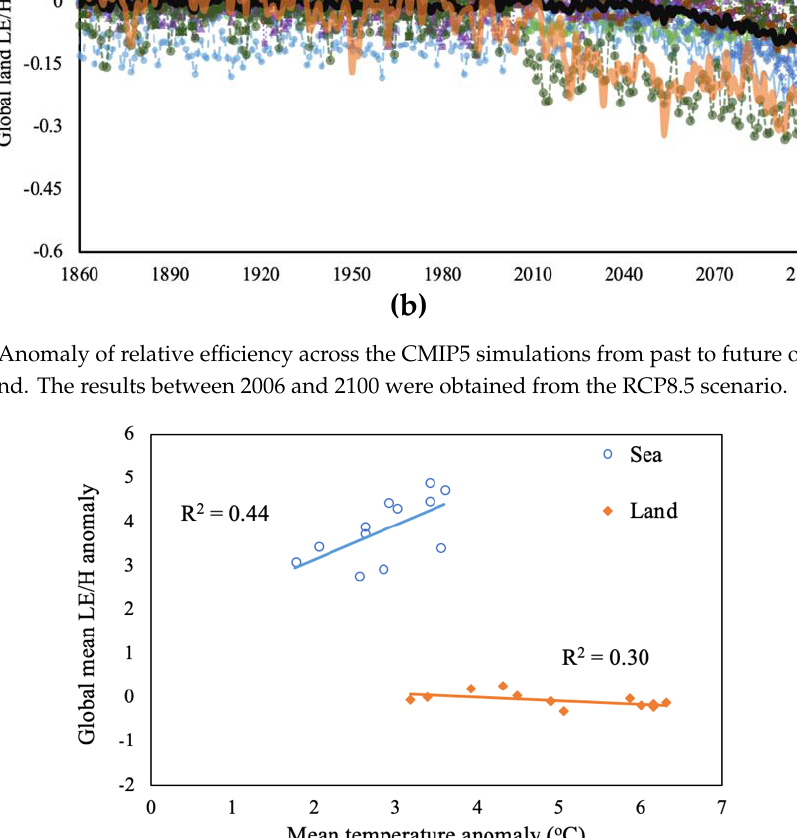
Figure 3. Mean LE / H anomaly and mean temperature anomaly between 1860 and 2100 over global Figure 3. Mean LE/H anomaly and mean temperature anomaly between 1860 and 2100 over global land and sea surfaces from the RCP8.5 land and sea surfaces from the RCP8.5 scenario.